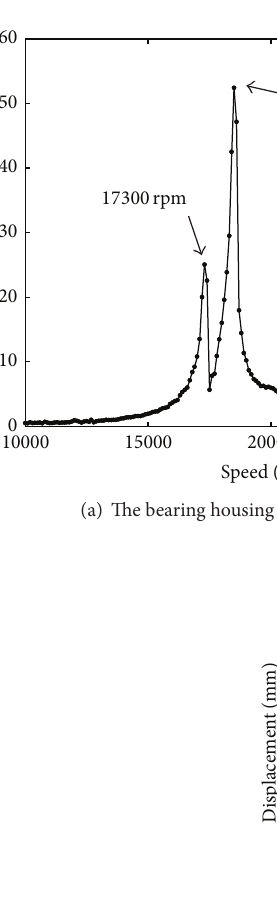
different speeds, according to the asymmetric stiffness equa- tion (11). Figure 6 shows that subharmonic resonance appears under the high speed and superharmonic resonance appears when the speed is higher than the second-order critical